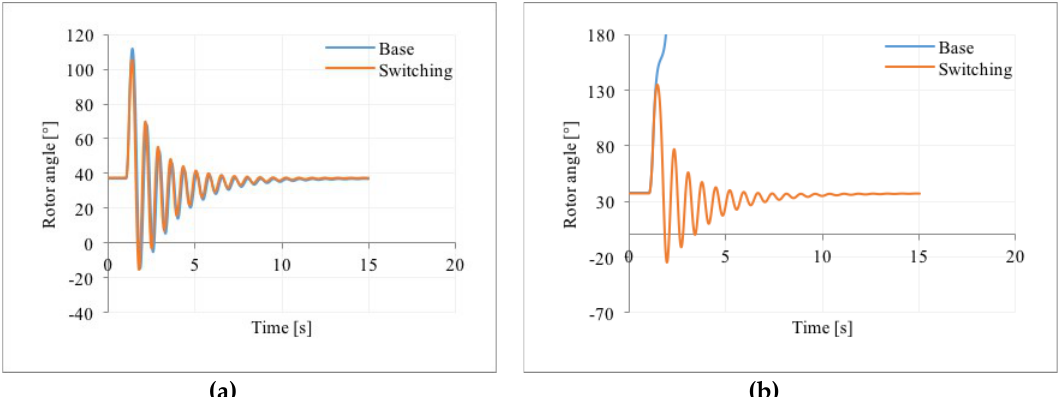
Figure 12. Rotor angle of the synchronous machine of Area 1 for a three-phase fault on Area 1 side: ( a ) Time results for clearing fault time t clear = 170 ms; ( b ) Time results for clearing fault time t clear = 201 ms (critical clearing time t CCT ).